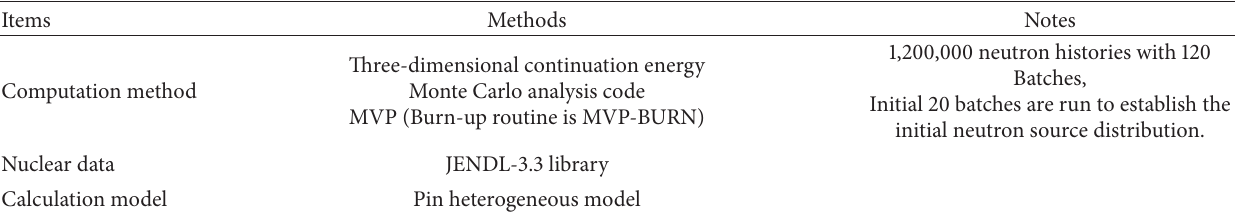
Table 2: Analytical method.